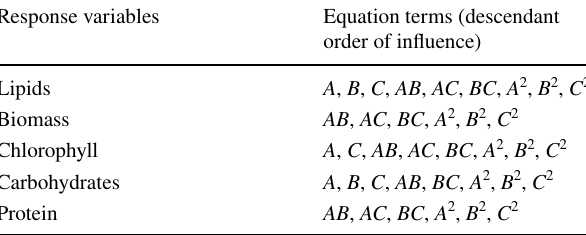
Factors: A -NaNO 3 , B -K 2 HPO 4 , C -ferric